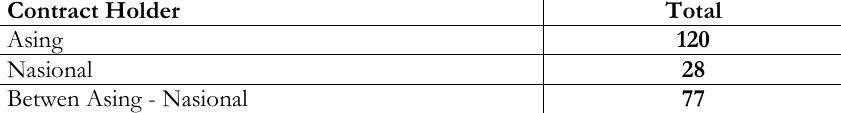
Mastery of Oil and Gas Mining Contracts until 2013